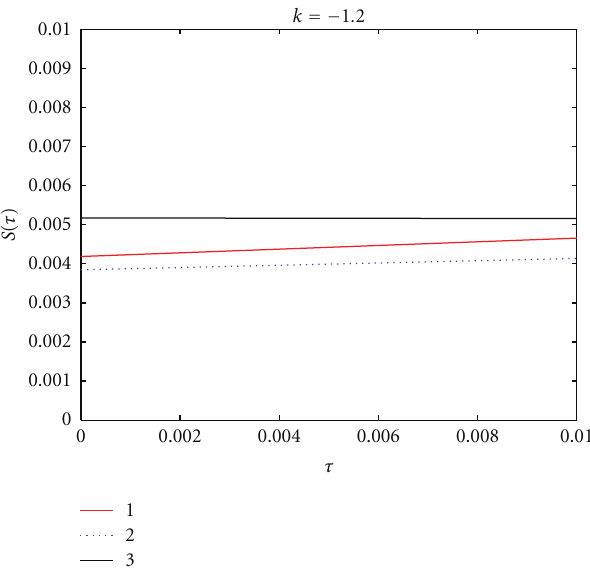
Figure 9: The relationship of similarity function S ( τ ) and τ under k = − 1 . 2 (enlarged part of Figure 8).